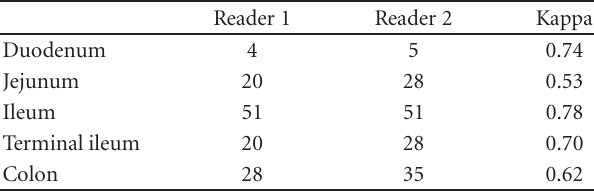
Table 2: Bowel segment a ff ected by acute or chronic crohn’s